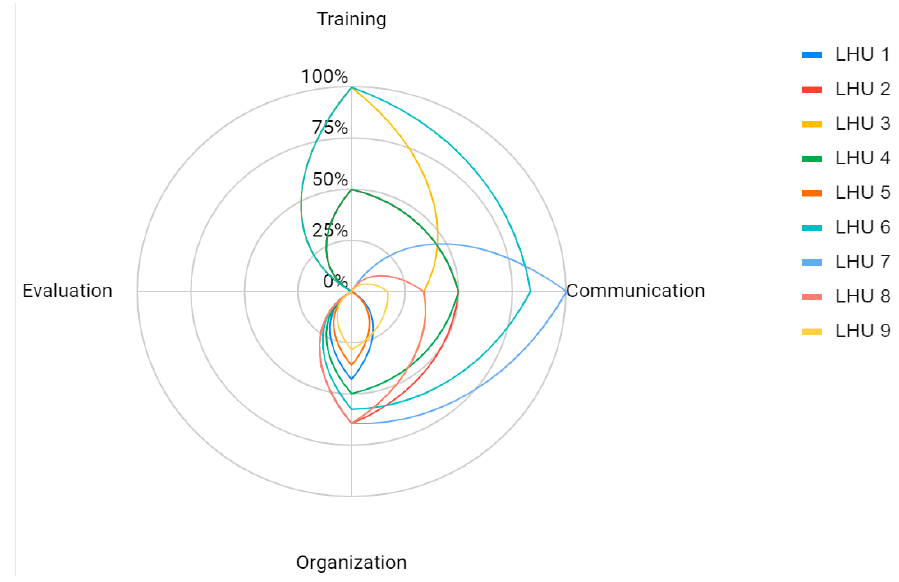
Figure 2. Overall results of the survey by Local Health Unit (LHU).